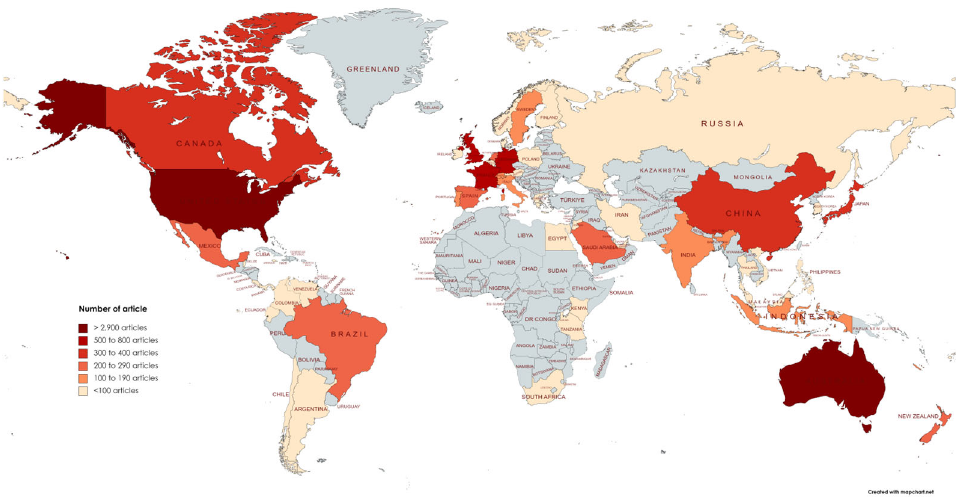
Figure 4. Nations publishing the most research on coral reefs and climate change generated from the freely editable map chart website (https://www.mapchart.net/world.html (accessed on 10 January 2023)).